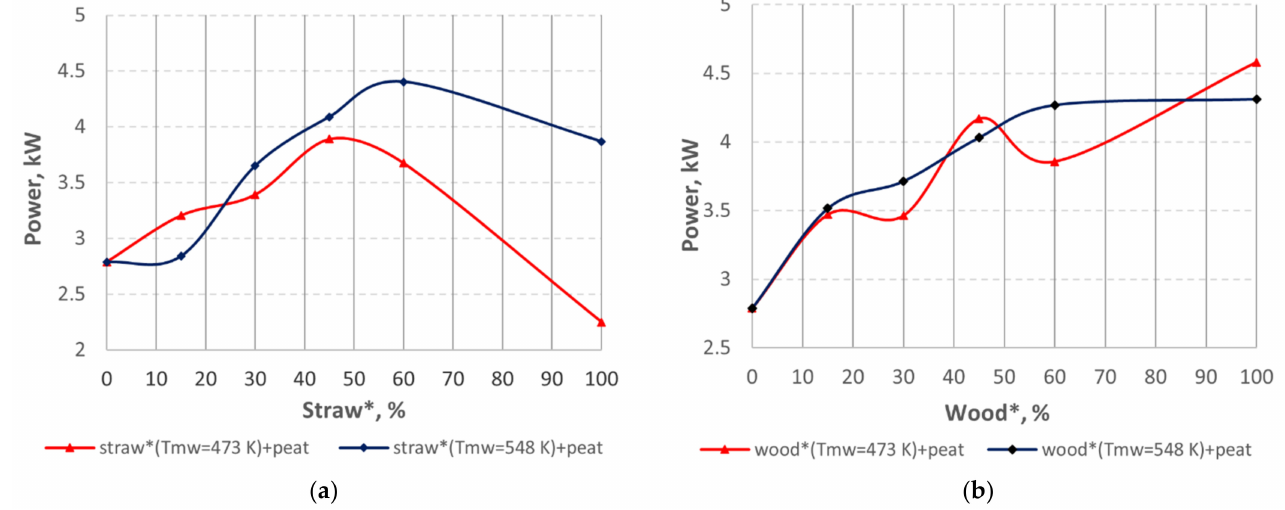
Figure 5. Effect of changes (variations) in pre-treatment temperature and composition of selectively pre-treated wheat straw* ( a ) and wood* ( b ) blends with raw peat pellets on the average values of heat